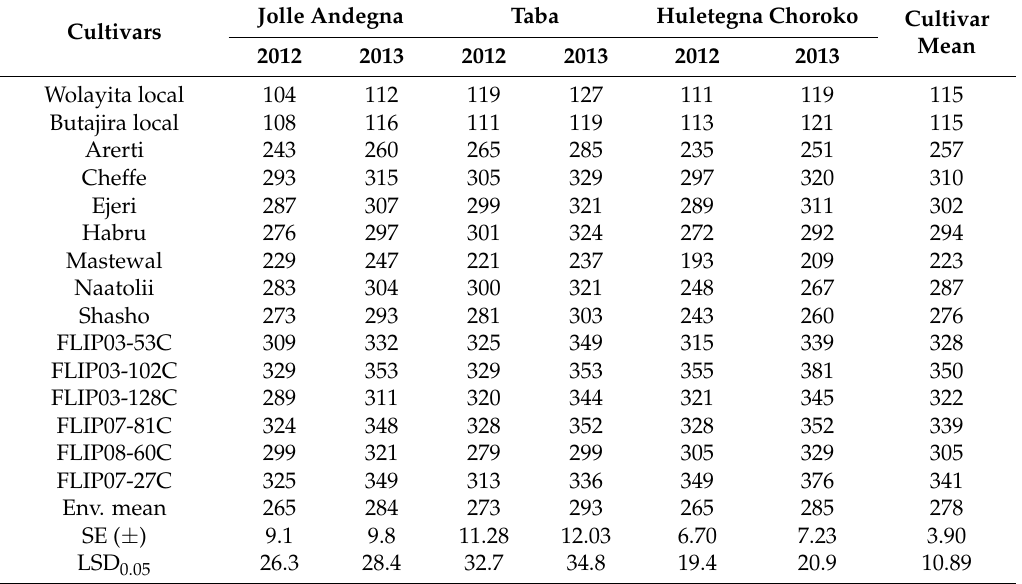
Table 5. Thousand seed weight (g) of 15 chickpea cultivars and breeding lines tested under zinc fertilized soil across three locations in southern Ethiopia during the 2012 and 2013 growing seasons.